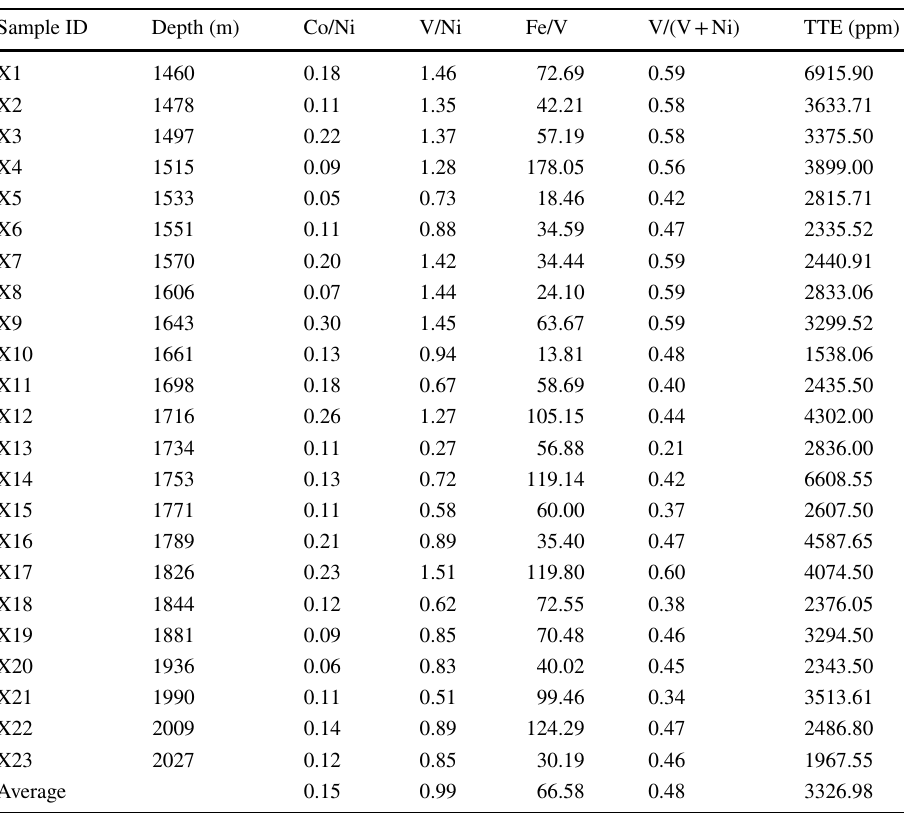
Table 3 Geochemical parameters for kerogen samples from Well X